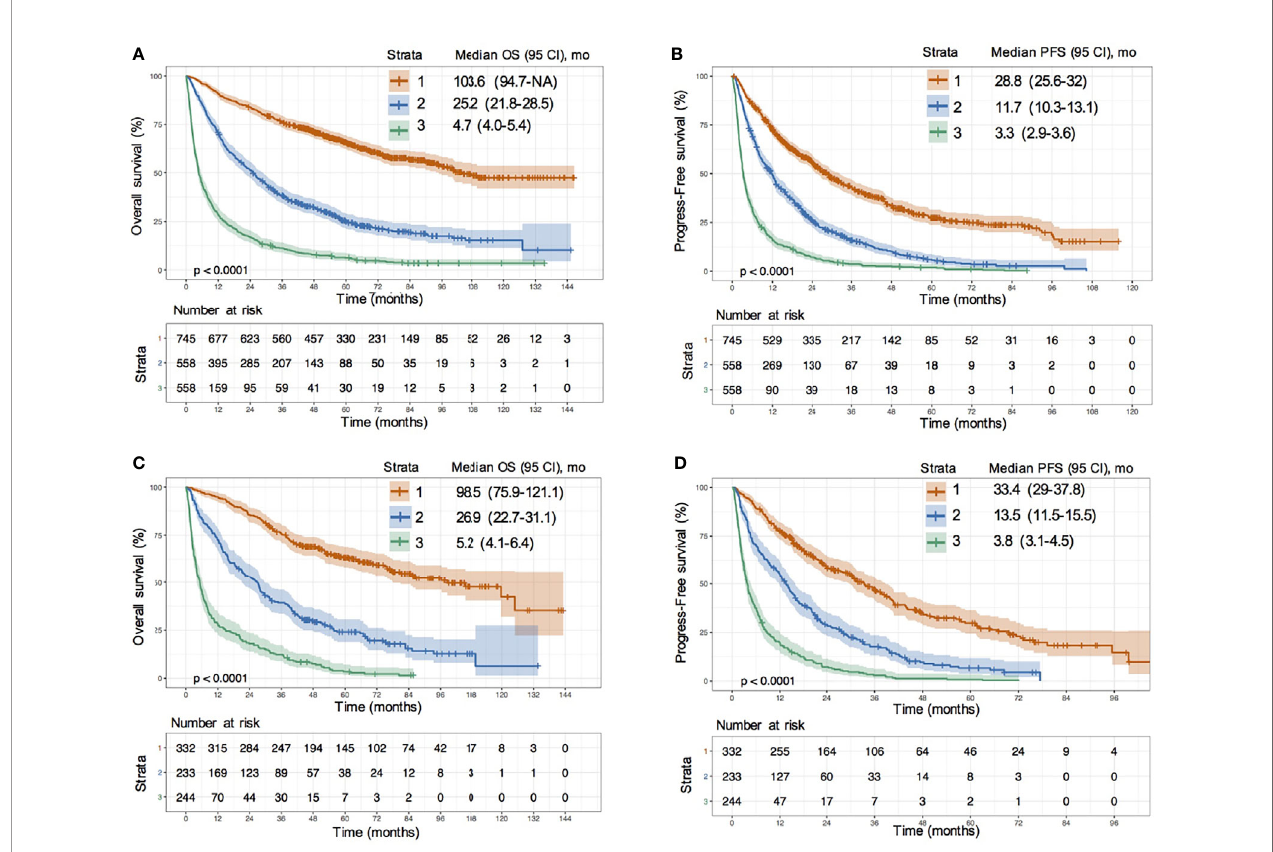
FIGURE 4 | Risk strati fi cation survival analysis of HCC patients divided by ANN model. (A, B) KM survival curves of overall survival (OS) (A) and progression-free survival (PFS) (B) in training cohort; (C, D) KM survival curves of OS (C) and PFS (D) in validation